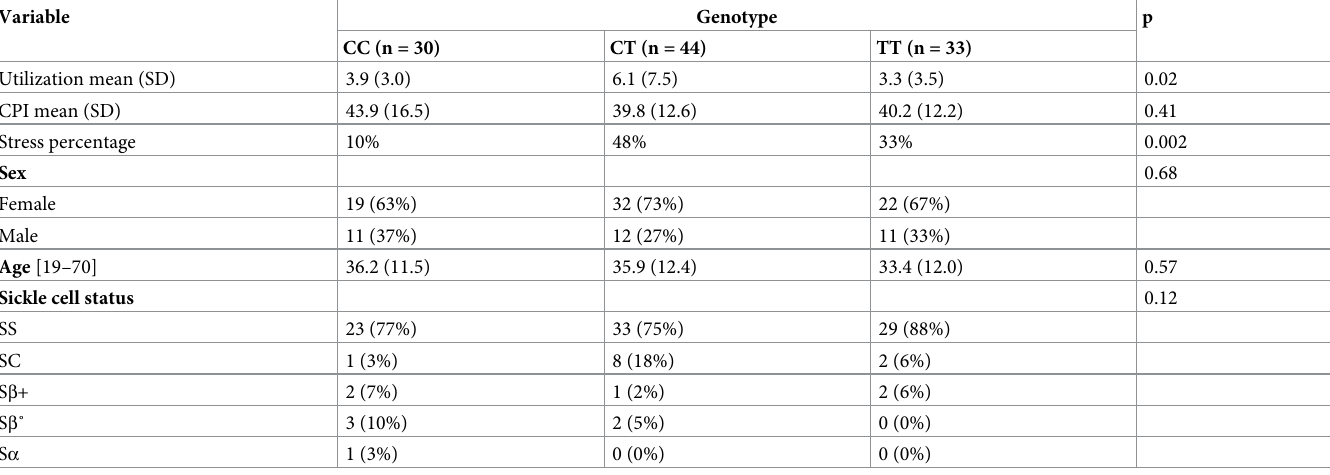
Table 2. Bivariate associations between genotypes and phenotypic